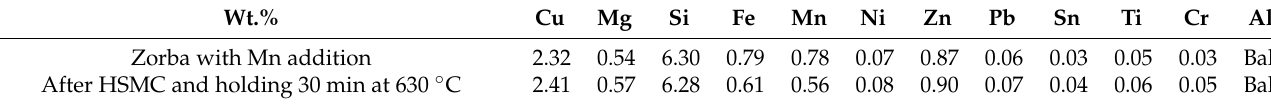
Figure 6. ( a ) Equilibrium phase diagram of the as-received Zorba cast fraction–xMn system, ( b ) Liquid composition of Zorba cast fraction alloy with the addition of 0.8 wt.% Mn for the second trial. Table 4. Chemical composition of modified Zorba cast fraction before and after de-ironing by high-shear melt conditioning. Wt.%